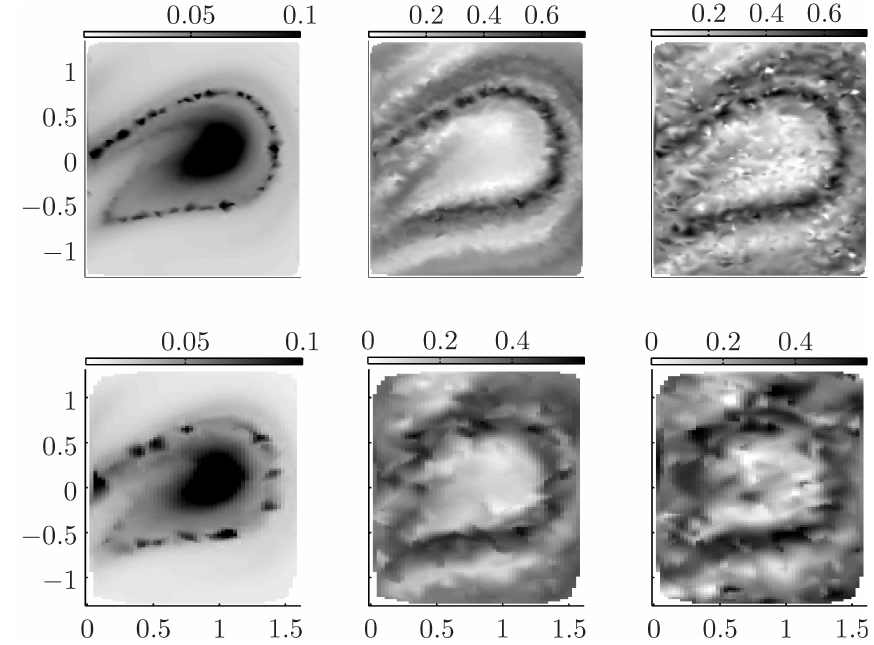
Fig. 5. (left) d mean -field (middle) FTLE-field produced using the Lekien and Ross (2010) method, and (right) FTLE-field produced using the conventional method computed using (top) 2550 and (bottom) 640 randomly distributed simulated drifters advected by the Duffing Oscillator